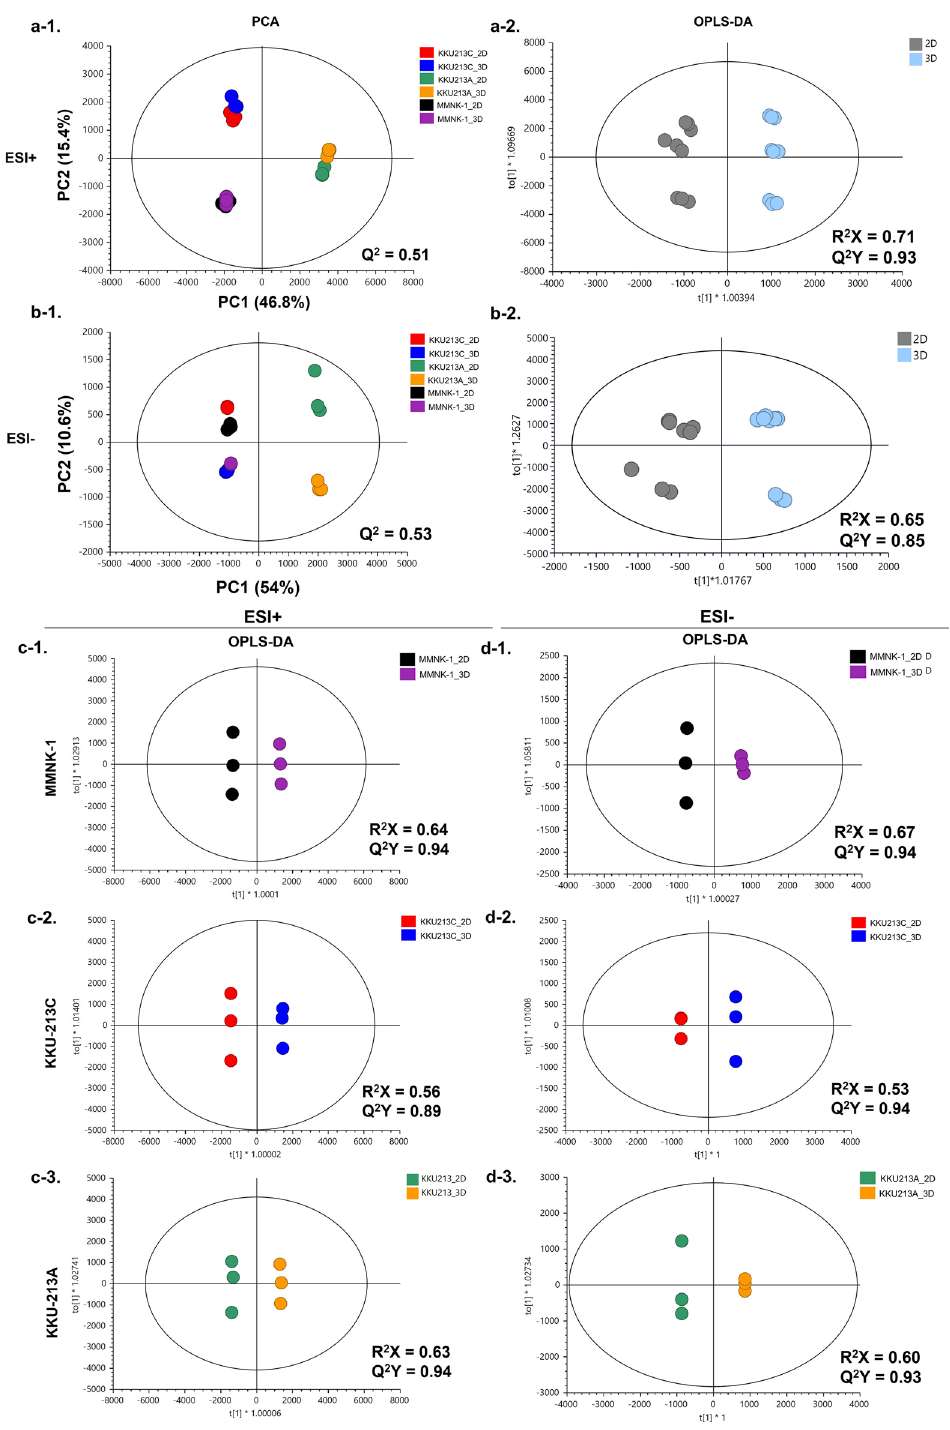
Figure 3. Multivariate statistical analysis based on the metabolomic profiling data sets of 2D culture and 3D MCS of CCA and cholangiocyte cell lines. ( a-1 , b-1 ) PCA score plots and ( a-2 , b-2 ) O-PLS-DA score plots based on UHPLC-ESI-Q-TOF-MS/MS data set of 2D and 3D from CCA and cholangiocyte cell lines . For individual cell line analysis, the left and right panels represent ESI + mode (1) and ESI- mode (2). ( c ) O-PLS-DA score plots base on UHPLC-ESI-Q-TOF-MS/MS data sets of 2D vs. 3D detected in ESI + ionization mode. ( d ) O-PLS-DA score plots base on UHPLC-ESI-Q-TOF-MS/MS data sets of 2D vs. 3D detected in ESI- ionization mode. MMNK-1 presented in c-1 and d-1, KKU-213C presented in c-2 and d2, and KKU-213A presented in c-3 and d-3. The figures were plotted using SIMCA-14.1 (Umetrics, Sartorius Stedim